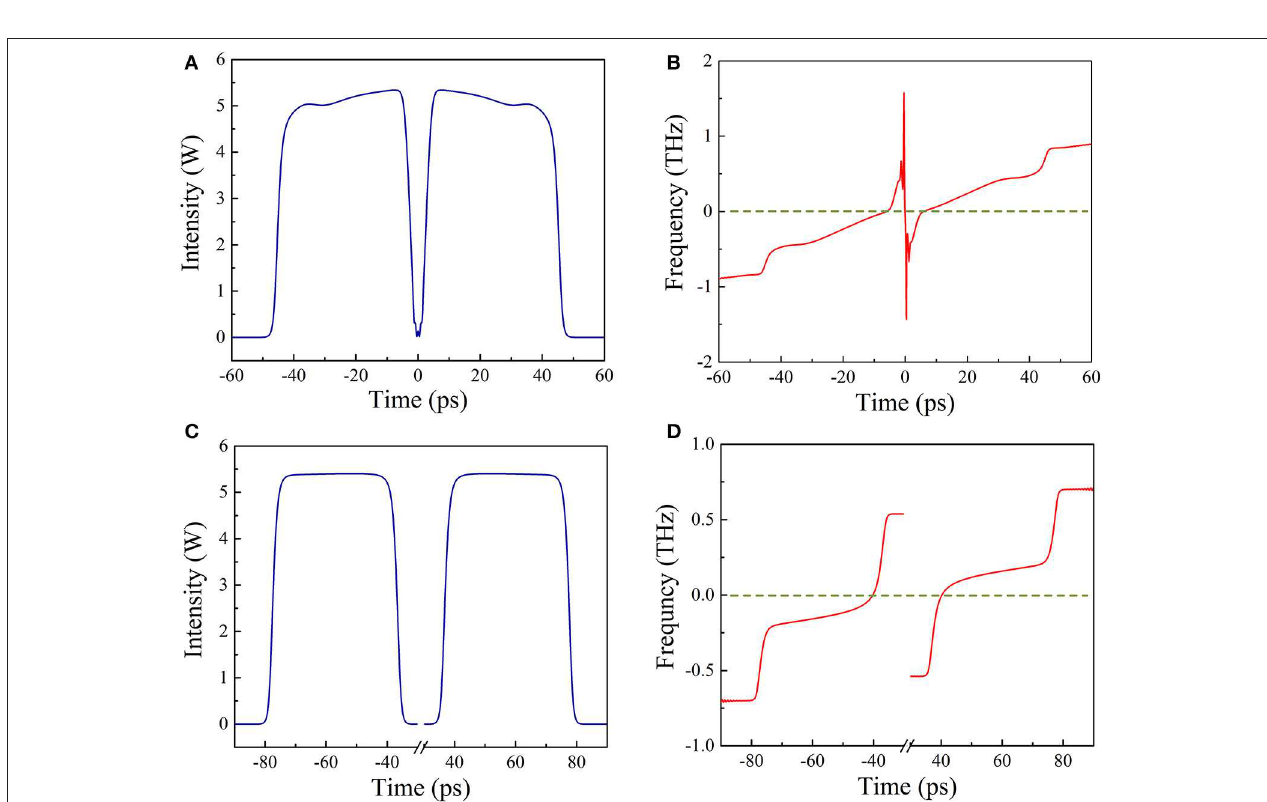
FIGURE 5 | Pulse properties at different roundtrips when E sat = 2 nJ. (A) Temporal profile at N = 120. (B) Instantaneous frequency profile at N = 120. (C) Temporal profile at N = 500. (D) Instantaneous frequency profile at N = 500.